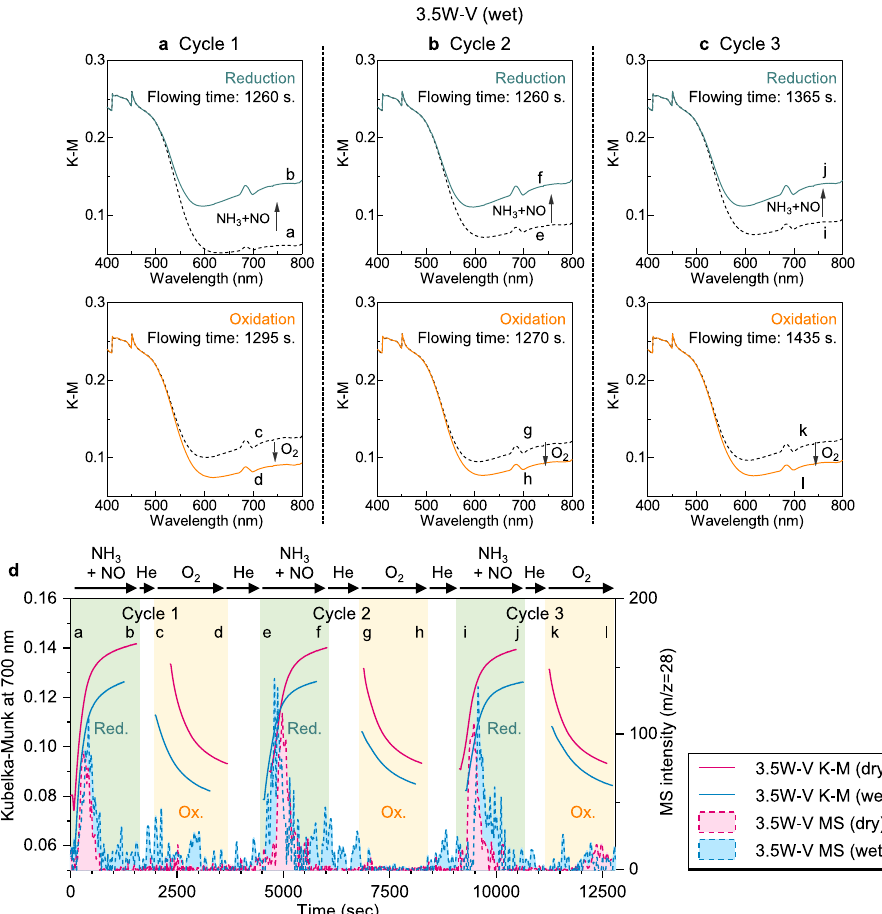
Fig. 9 Redox properties of W-substituted vanadium oxide (3.5W – V) under wet and dry conditions. Operando UV – Vis spectra of 3.5W – V for reduction (500 ppm NO + 500 ppm NH 3 ) and oxidation (8% O 2 ) half-cycles at 150 °C under a wet (2 vol% water) atmosphere for the a fi rst cycle, b second cycle, and c third cycle. d Change in the Kubelka – Munk unit at λ = 700 nm and MS intensity of N 2 as a function of time for 3.5W – V during NO (500 ppm) + NH 3 (500 ppm) and O 2 (8%) fl owing at 150 °C under a dry atmosphere and wet (2 vol% water) atmosphere. The characters a – l correspond to the points at which the UV – Vis spectra were